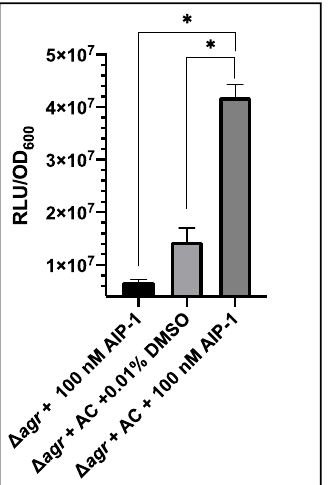
Figure 3. Impact of the addition of exogenous AIP-1 on bioluminescence produced by S. aureus USA300 ∆ agr P3-Gluc pSKermP2 agr AC. ∆ agr represents USA300 ∆ agr P3-GLuc and ∆ agr + AC represents USA300 ∆ agr P3-Gluc pSKermP2 agr AC. The data represent three technical repeats and three biological repeats for each sample and error bars displaying standard deviation. * p <